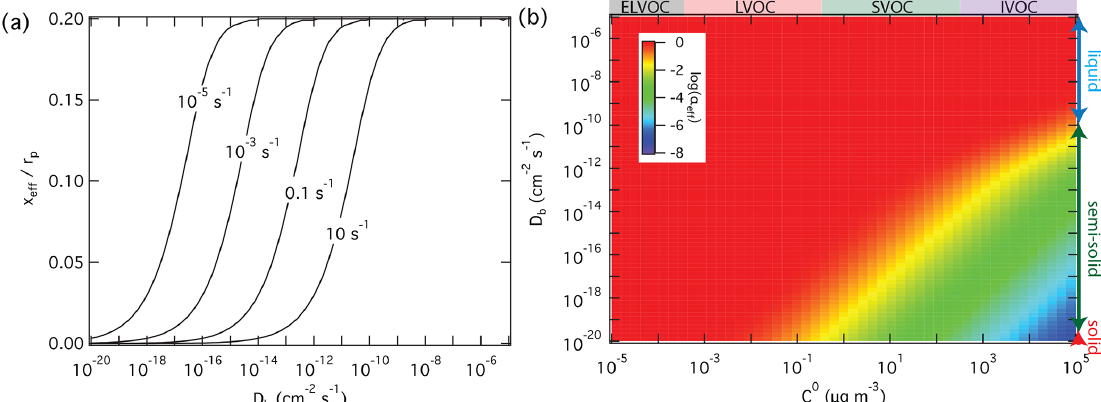
Figure 5. Effective penetration depths normalized by particle radius, x eff , and mass accommodation coefficients, α eff , for reactive uptake of organic compounds Z ( α s = 1, ω = 2 × 10 4 cms − 1 ) by liquid, semi-solid, or solid aerosol particles ( r p = 100nm, ρ p = 1gcm − 3 ) depending on pure compound volatility, C 0 , particle bulk diffusivity D b , and first-order bulk reaction rate coefficient, k b . (a) x eff calculated as a function of D b and k b = 10 − 5 to 10s − 1 . (b) α eff calculated as a function of C 0 and D b for k b = 0.1s − 1